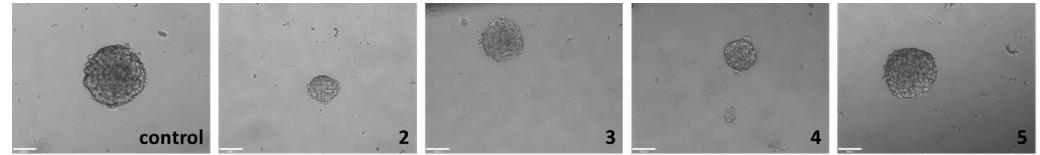
Figure 2. Representation of the number of mammospheres formed from HMLER-shEcad cell sus- pensions treated with 2 – 5 , L 2 , L 3 or salinomycin at 0.5 µ M, a non-lethal dose after 5 days incubation. Standard deviation was used to signify the associated errors. Student t -test, * = p < 0.05, ** = p < 0.01.